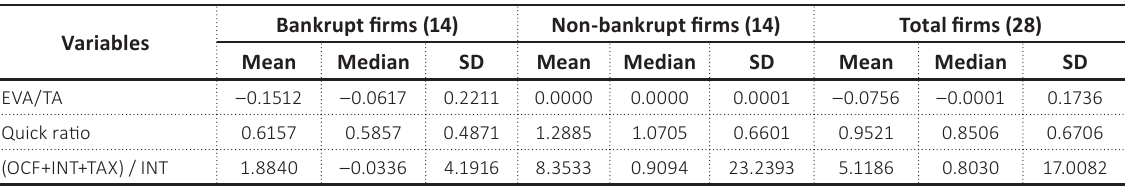
Table 12. Descriptive group statistics ( t